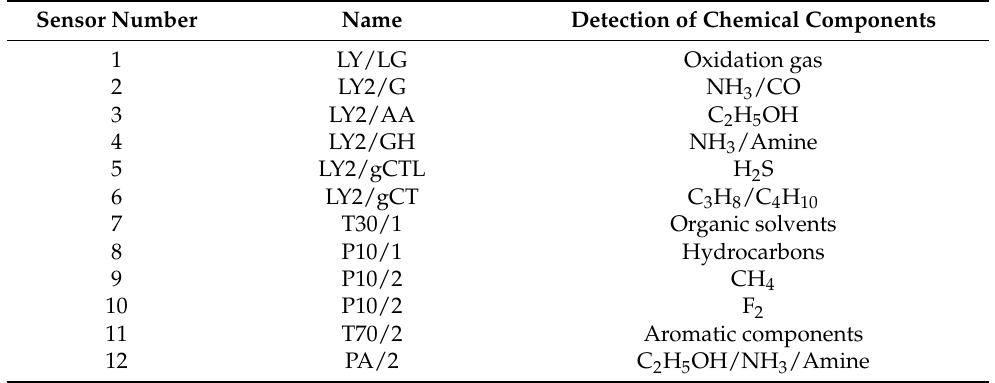
Table 1. Types of FOX 3000 electronic nose sensors and their specificity for chemical compounds. Sensor